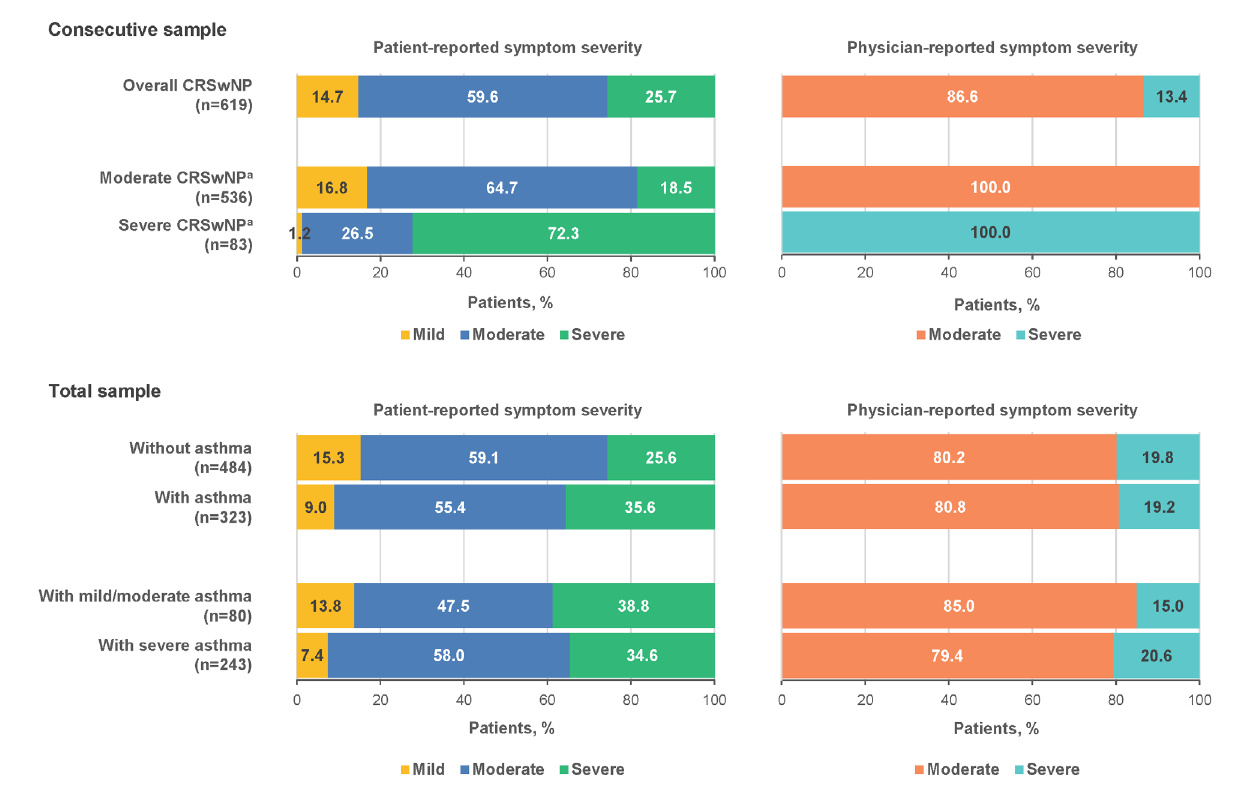
Figure 4. Overall severity of CRSwNP from matched patient/physician perspectives. a CRSwNP severity determined by physician for each patient based on physician’s clinical expertise and provided guidance to follow the European Position Paper on Rhinosinusitis and Nasal Polyps guidelines (2,10) and NP size scoring systems. Abbreviations: CRSwNP, chronic rhinosinusitis with nasal polyposis; NP, nasal